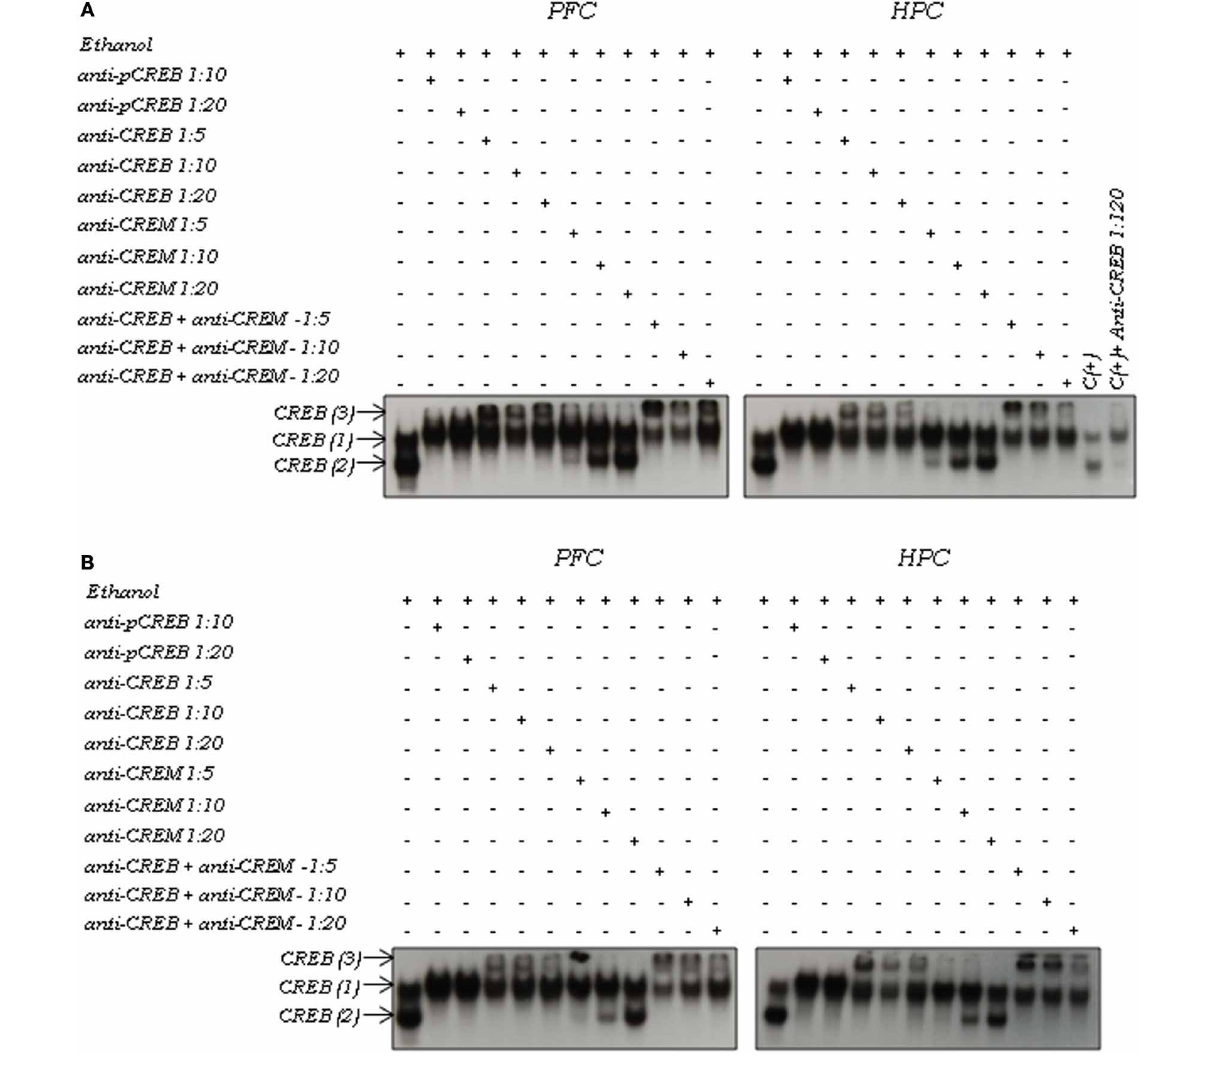
against pCREB (1:10 and 1:20), CREB (1:5; 1:10, and 1:20), and CREM (1:5; 1:10, and 1:20). The positions of the DNA-CREB complexes [CREB (1), CREB (2), and CREB (3)] and free probe are indicated by arrows. A nuclear extract was used as a positive control and also incubated with anti-CREB antibody